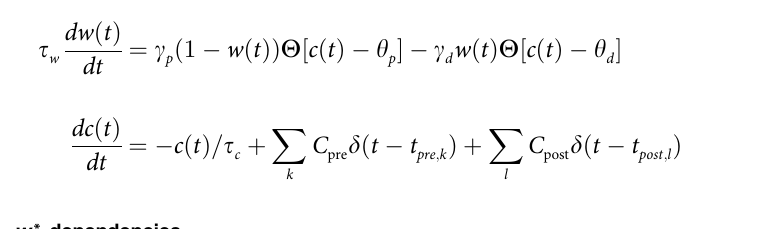
Table 2. Rate-based synaptic plasticity rules and their v * i − w * ij -dependencies. rule differential equation _ w ij feedforward w (cid:2) ij feedback w (cid:2) ij Hebb with hard boundaries Bienenstock-Cooper-Munro rule ... with fi xed- θ and hard boundaries ... with sliding threshold θ = θ [ t ] Hebb rule with weight-dependent scaling fi xed- θ BCM rule with weight-dependent scaling